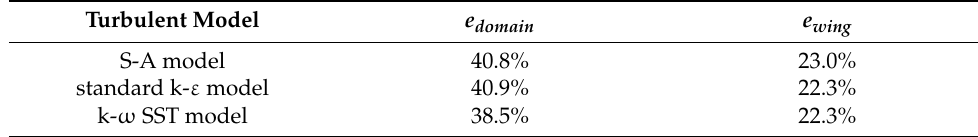
Table 8. Power imbalance error for three turbulent